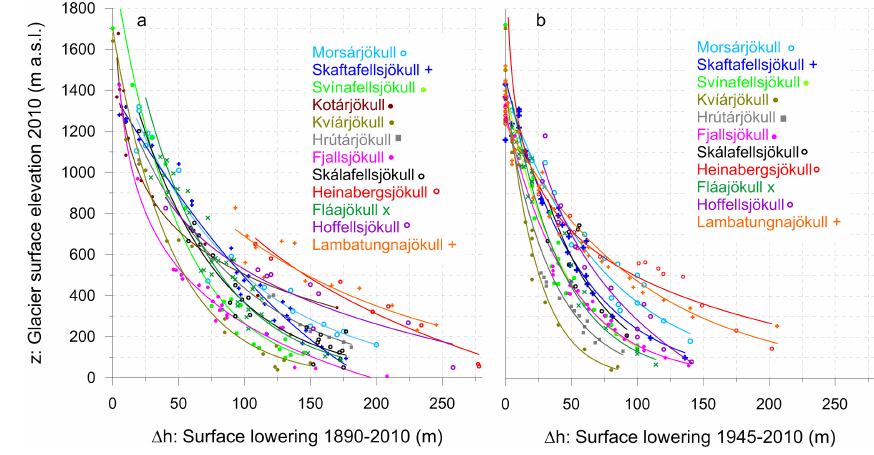
Figure 10. Average surface lowering of every 20m altitudinal interval of the outlets of southeast Vatnajökull. (a) Between ∼ 1890 and 2010 (modified from Hannesdóttir et al., 2014). The ∼ 1890 glacier surface elevation in the accumulation area is derived from historical photographs, survey elevation points on the 1904 maps and the aerial images of Loftmyndir ehf., and in the ablation area it is mainly deduced from glacial geomorphological features. (b) Between 1945 and 2010. The glacier surface lowering in the accumulation area is based on comparison of the size of nunataks as observed on the original aerial images of 1945 and the lidar DEMs. No 1945 DEM is available for